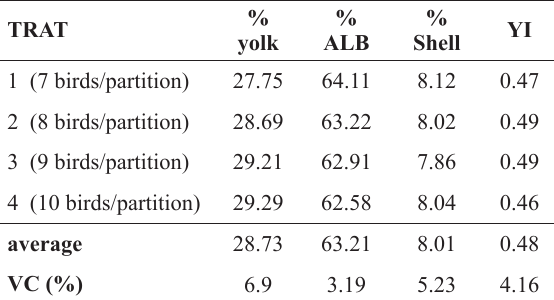
Density effects over % of egg yolk (% yolk), % of albumem (% ALB), shell % (% shell) and Yolk indices (YI).